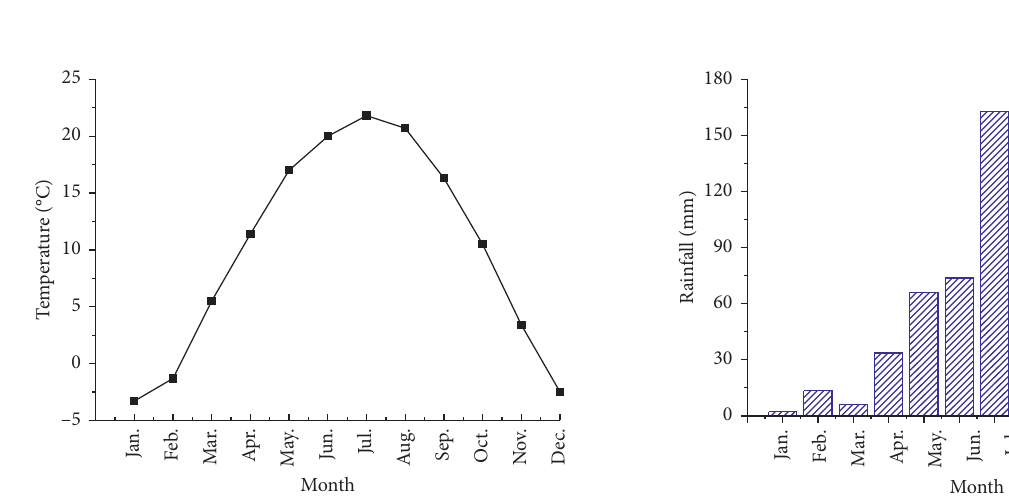
Figure 2: Core selection scheme and field photo.